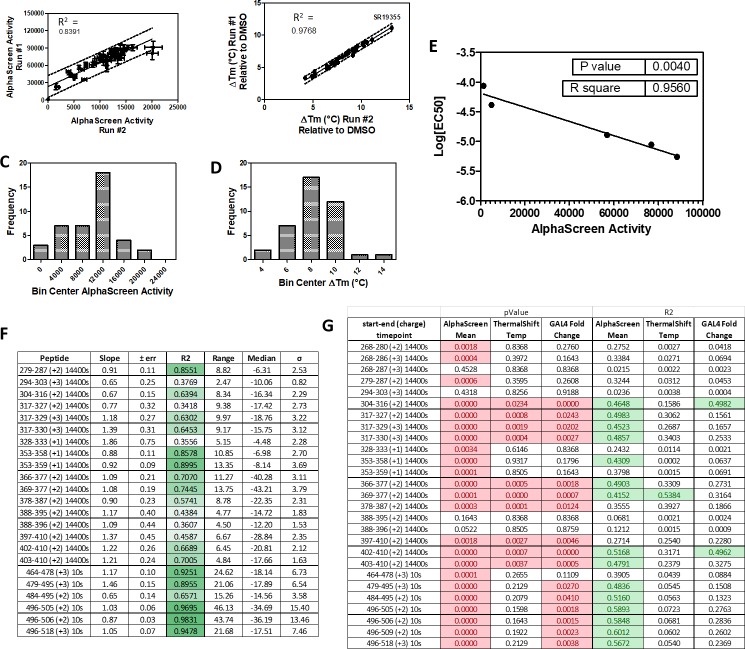
Summary and reproducibility of biochemical and two timepoint HDX-MS screening data (related to Figures 3 and 4).38 RORγ modulators were tested in AlphaScreen-based peptide recruitment assays and thermal shift assays in two separate preparations of compounds and protein to assess reproducibility. The run to run comparisons are shown in panel (A and B). The distributions of the compound activities are shown in panels (C and D). AlphaScreen-based peptide recruitment activity correlated with fluorescent polarization-based peptide recruitment EC50 values as shown in panel (E). The Reproducibility of 2 timepoint HDX-MS screening was performed using two batches of protein and the results of the run-to-run correlations are shown in panel (F).